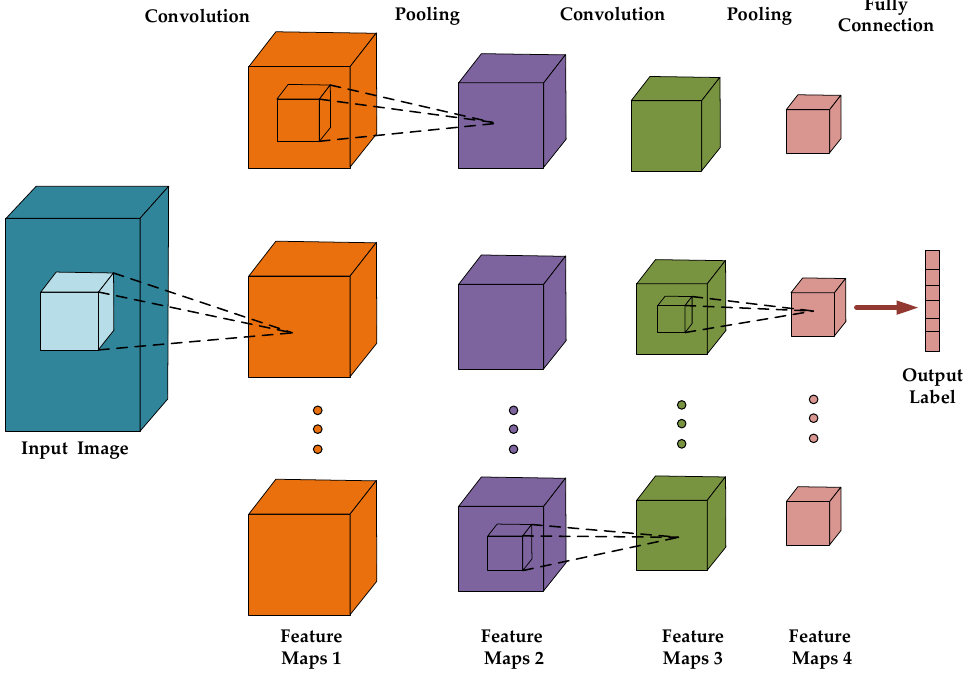
Figure 2. Illustration of typical 3DCNN structure.